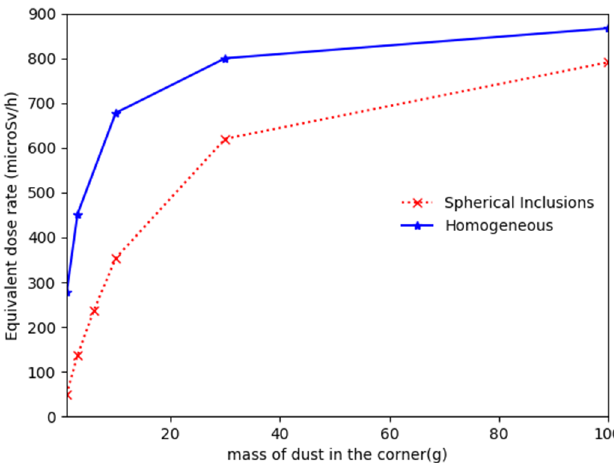
Fig. 8. Sphericalinclusionmodel,Gammasimulationwithspheres of constant radius of 0.05cm, constant density of 6.6g/cm 3 and variable packing fraction (PRSD are inferior to 1%).